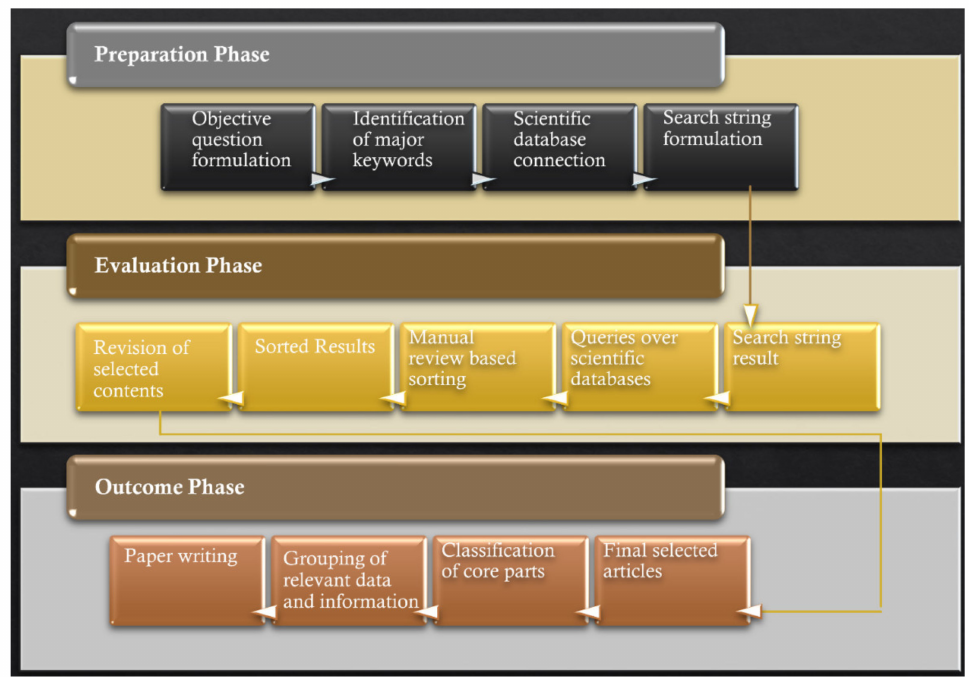
Figure 1. Review